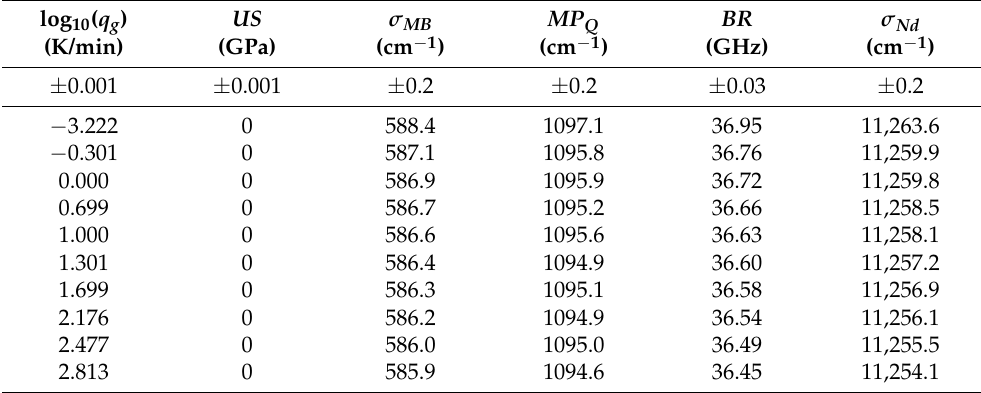
Table A2. Experimental data and spectroscopic observables of the q g 2 sample used for the multiple linear regression model.